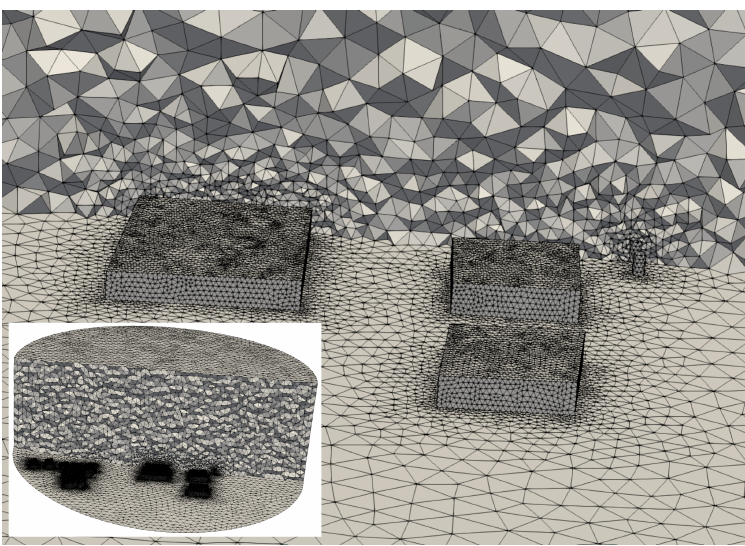
Figure 1. Topographic model of the harbour area of Tromsø. The ( a ) vertical, ( b ) lateral and ( c ) oblique view of the topographic model is shown. The vertical scale has been magnified ( × 5) for clarity.